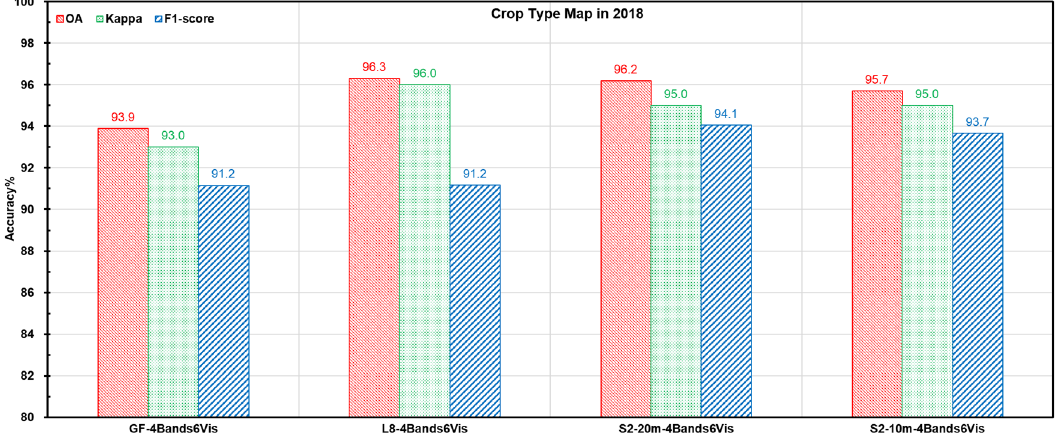
Figure 4. The accuracies of experiment 2.